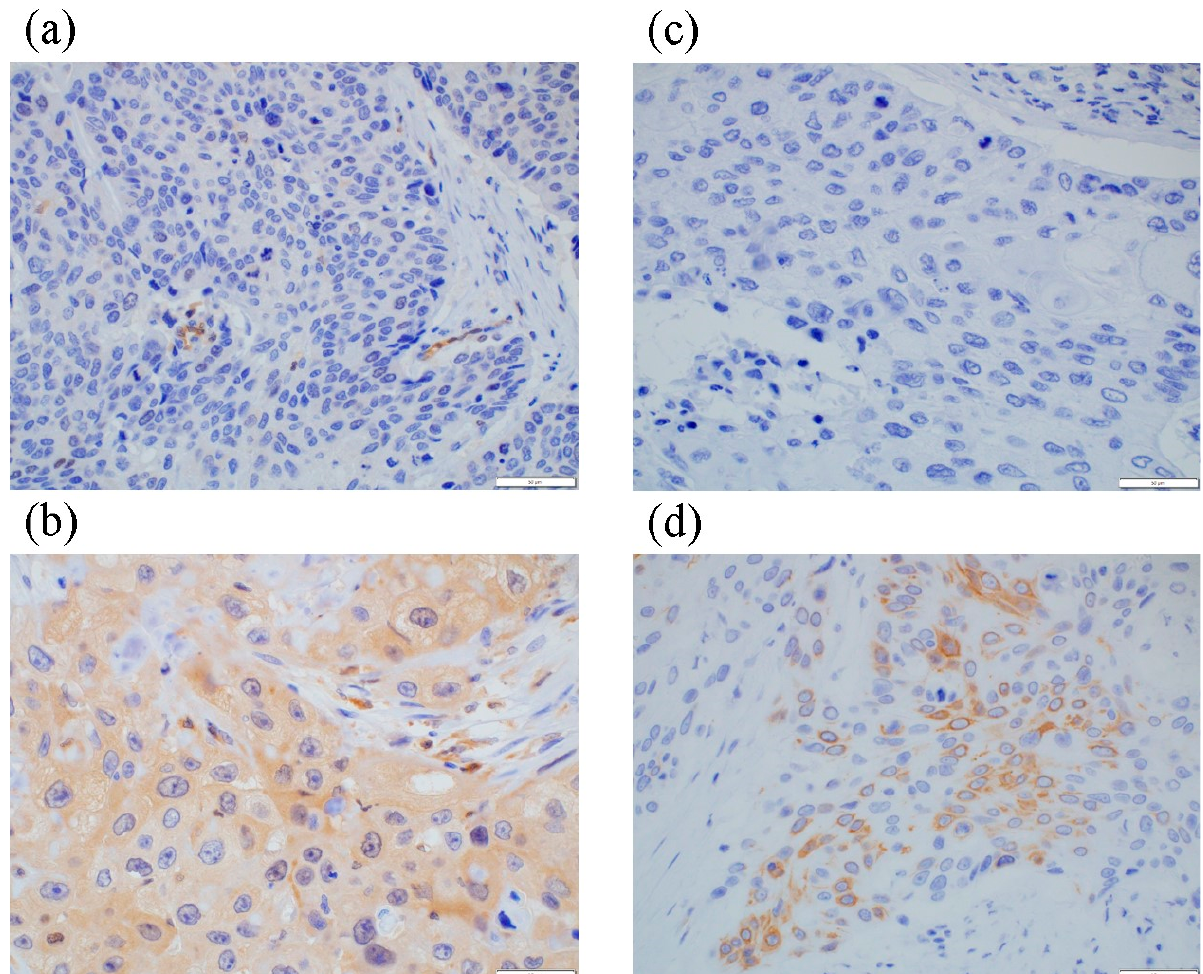
Figure 1. Representative illustrations of MLKL and pMLKL immunohistochemistry. ( a ) Low MLKL and ( b ) high MLKL status showing representative cases of diffuse and marked immunoreactivity in the cytoplasm of carcinoma cells. ( c ) Low pMLKL and ( d ) high pMLKL status showing representative cases demonstrating pMLKL immunoreactivity in the cytoplasm and plasma membrane of carcinoma cells. Table 1. Post-NAC expression status of the markers and its correlation with clinicopathological factors. Variable